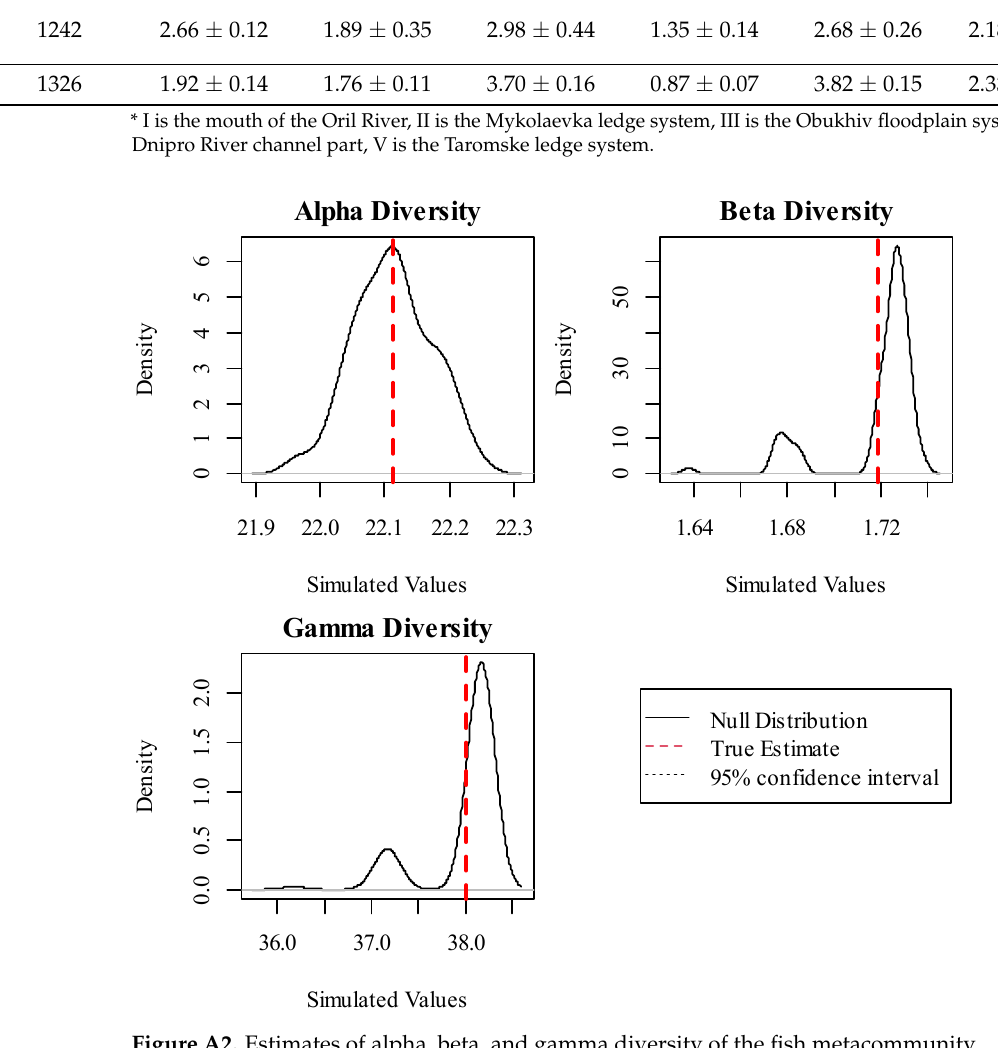
Figure A2. Estimates of alpha, beta, and gamma diversity of the fish metacommunity. Table A4. Decomposition of the eigenvalues (Covar = sdR × sdQ × Corr). Total inertia: 0.05609.